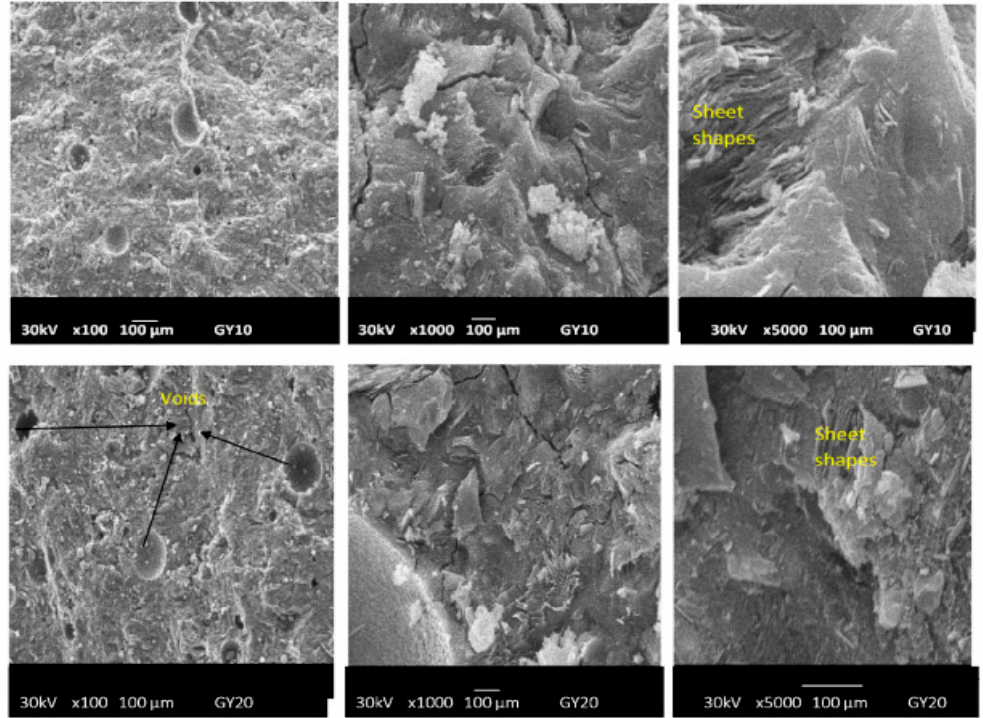
Figure 13. Micrograph images of geopolymer materials with addition of goethite containing kaolinite. (GY10, GY20) with magnifications of x100, x1000, x5000 (from left to right ).